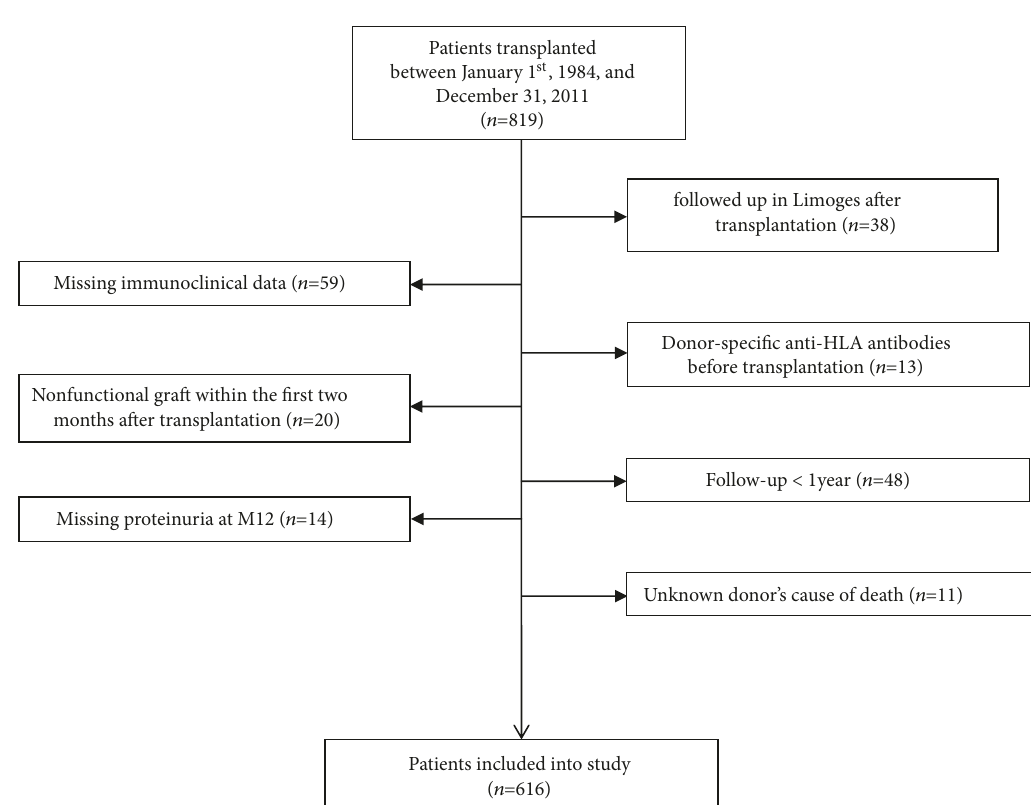
Figure 1: Flowchart showing selection of renal transplant recipients included in the